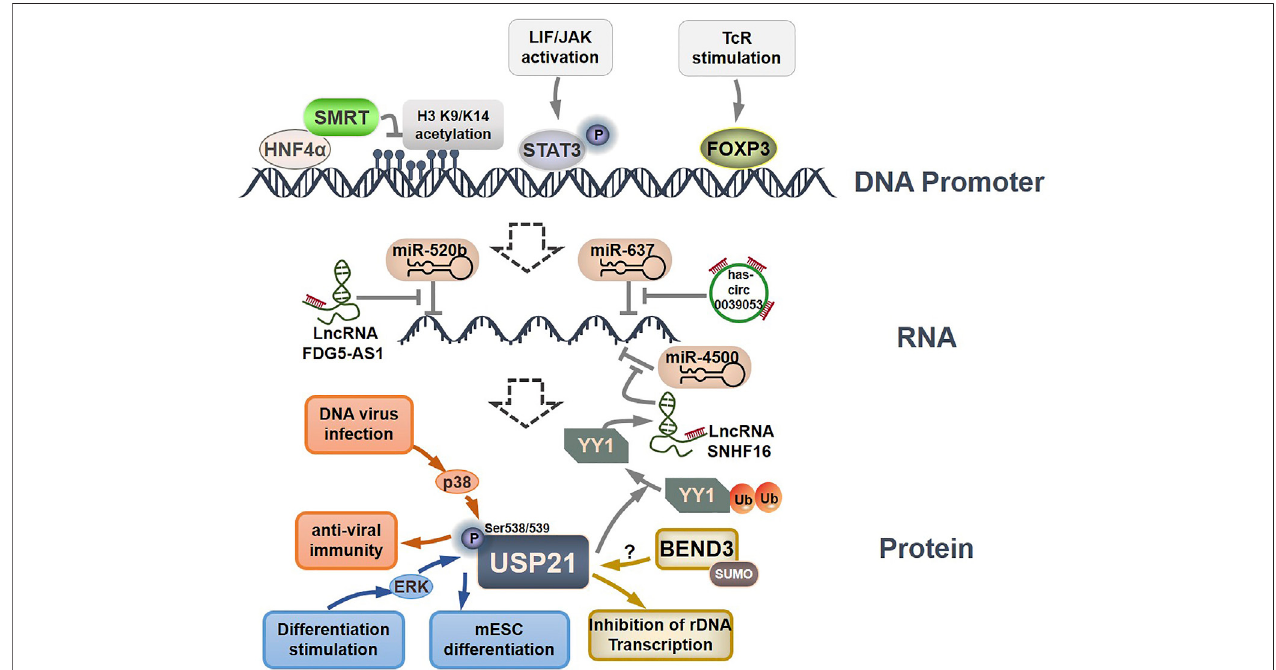
FIGURE4| RegulationofUSP21expression.HNF4 α ,STAT3,andFOXP3candirectlybindtotheUSP21promotertomodulatethetranscriptionofUSP21.Several lncRNAs regulate USP21 expression by sponging miRNAs. ERK and p38 phosphorylated USP21 to regulate its substrate binding af fi nity, and SUMOylated BEND3 stabilize USP21 in an indistinct